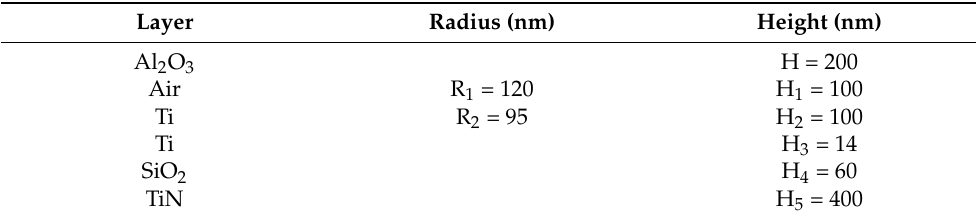
Table 2. All optimized structural parameters used in the simulation.